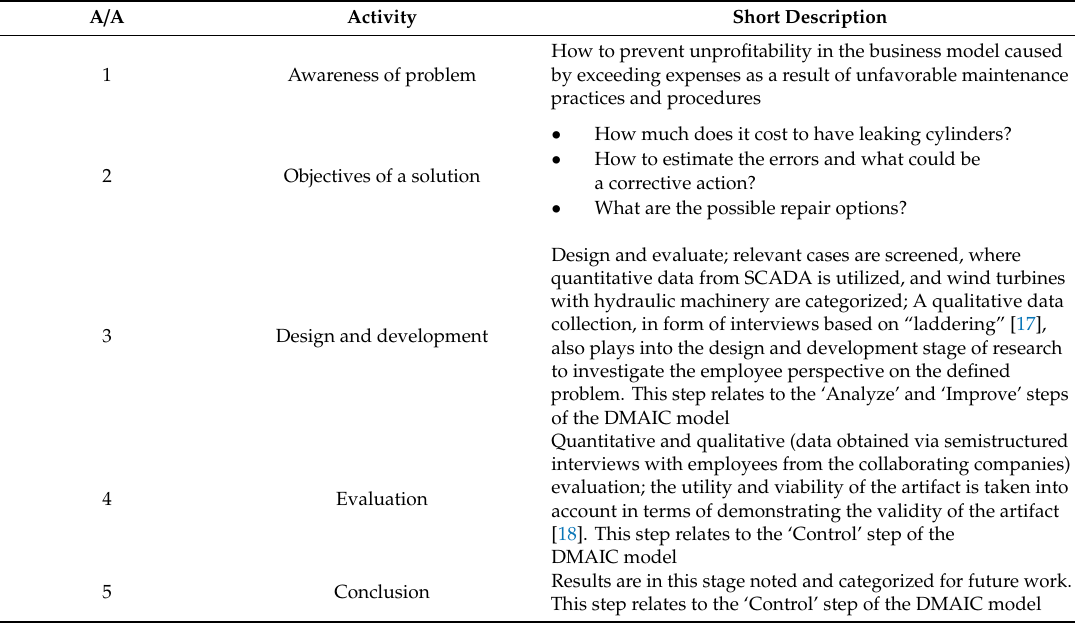
Table 1. Paper’s Structure.